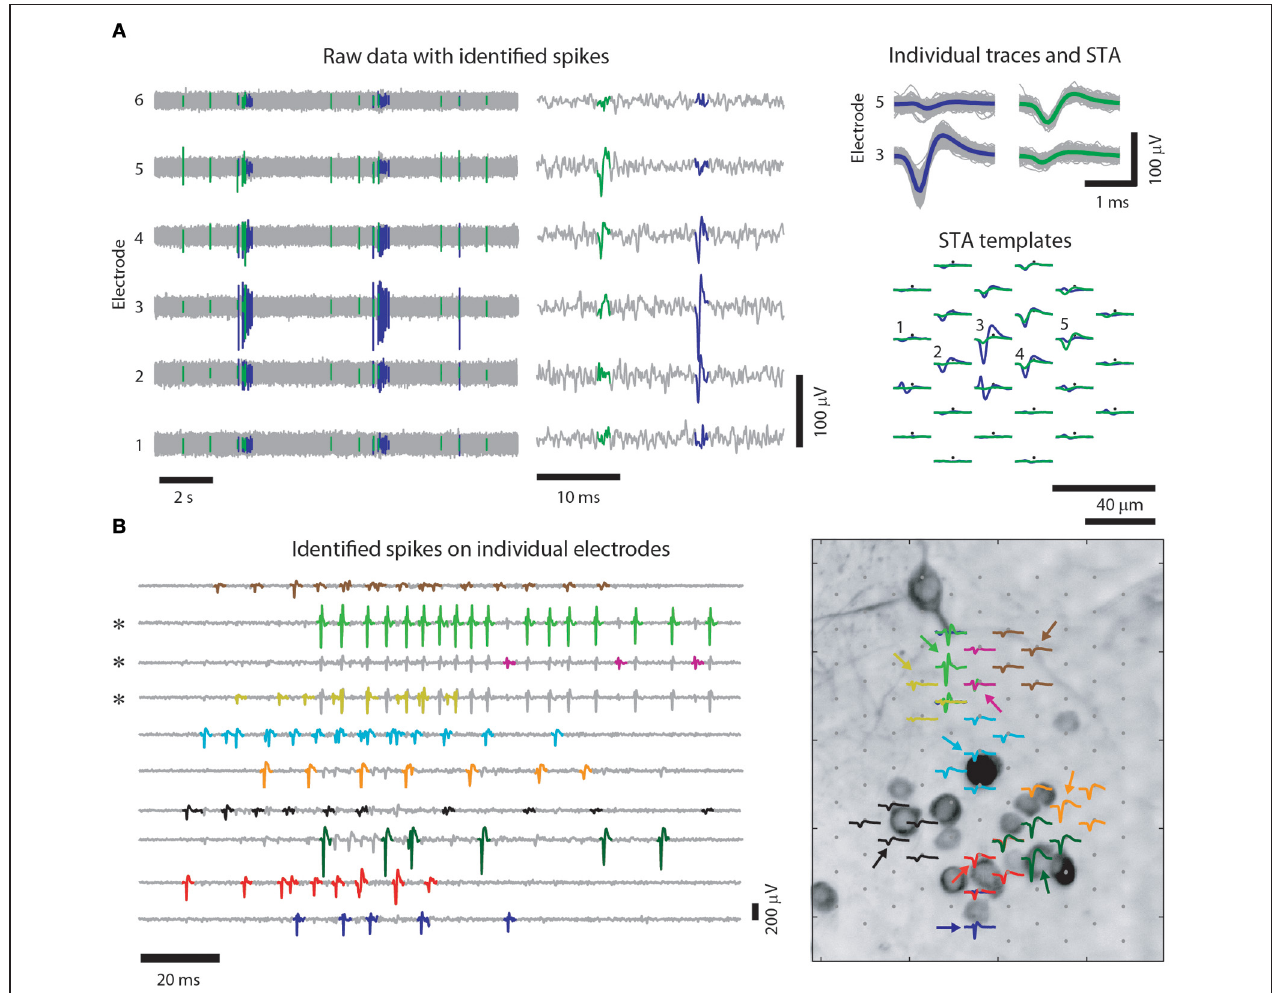
FIGURE 2 | Spike sorting for high-density multi-electrode recordings of cultured neurons. (A) Example recording of 6 out of 102 electrodes of a HDMEA (left), where mainly two neurons were recorded from, and a close up on two spikes (middle) (similar figure as in Frey et al. (2009a), however, with cultured cortical neurons). Spikes of individual neurons are recorded by multiple electrodes. Colored traces are identified spikes from two neurons. Note that on the trace of electrode 4, the two spikes are hardly distinguishable and that only combining the information of different channels enables unambiguous spike assignment, see also (Fiscella et al., 2012). (Right top) Several superimposed spike traces of the two neurons. The colored traces are the spike-triggered averages (STAs) of the two neurons on the respective electrodes. The templates of the two neurons